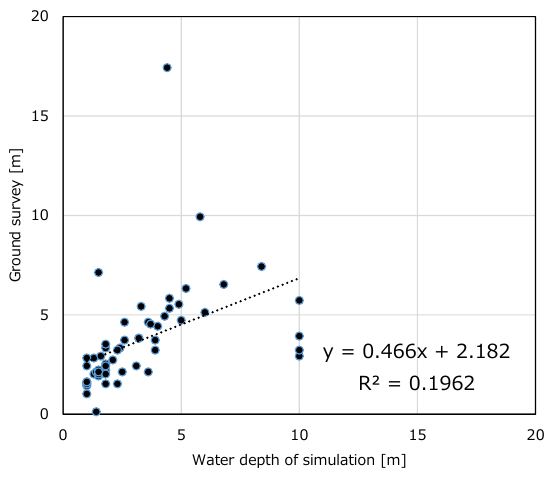
Figure 6. Comparison with ground truth